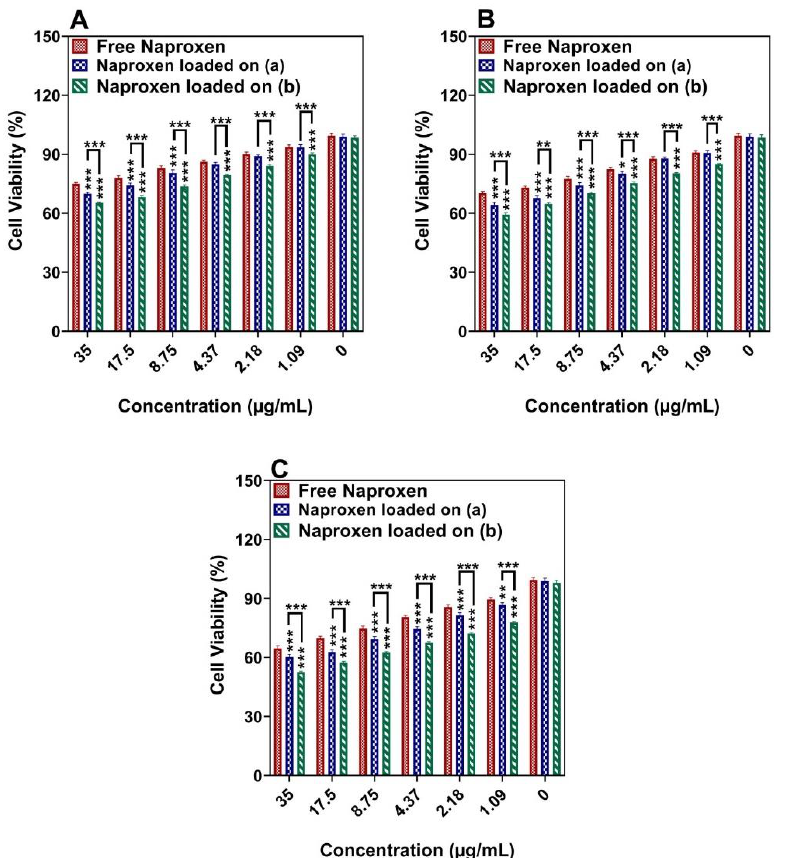
Figure 7. The effect of free drug and drug-loaded carriers (a) Ni 1−x Co x Fe 2 O 4 @Methionine NPs and (b) Ni 1−x Co x Fe 2 O 4 @Methionine@PEG NPs on the viability of MCF-7 cells after incubation for ( A ) 24 h, ( B ) 48 h, and ( C ) 72 h. Data are expressed as mean ± SD ( n = 5) (*** p < 0.001, ** p < 0.01, * p < 0.05).